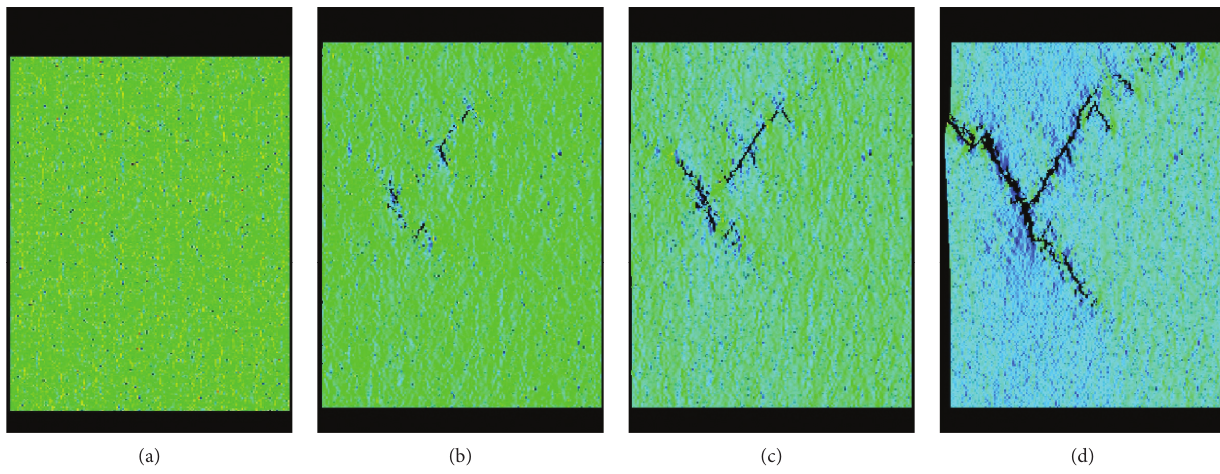
Figure 5: Macroscopic failure of rock mass when the ratio of height to diameter is equal to